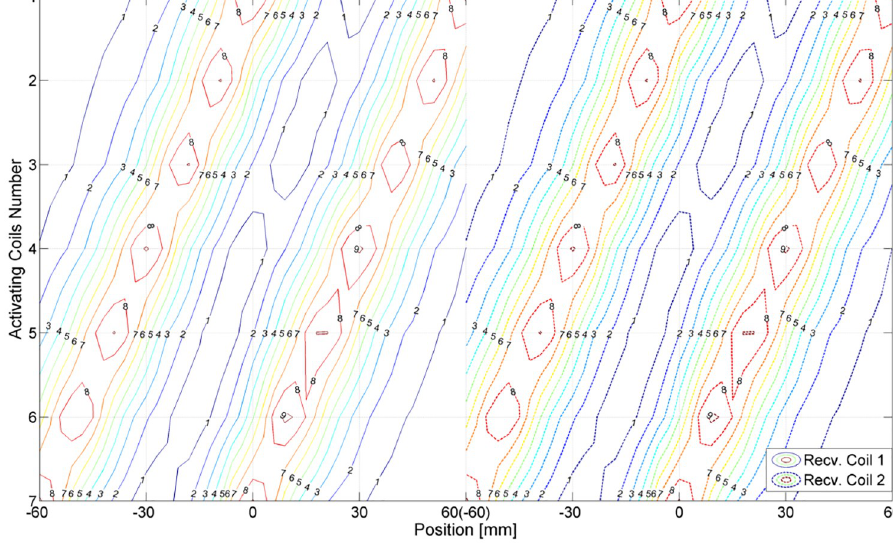
Fig 12. Contour graph to find errors. It is the result of combining two single coil graphs separated by the same distance as the developed system.